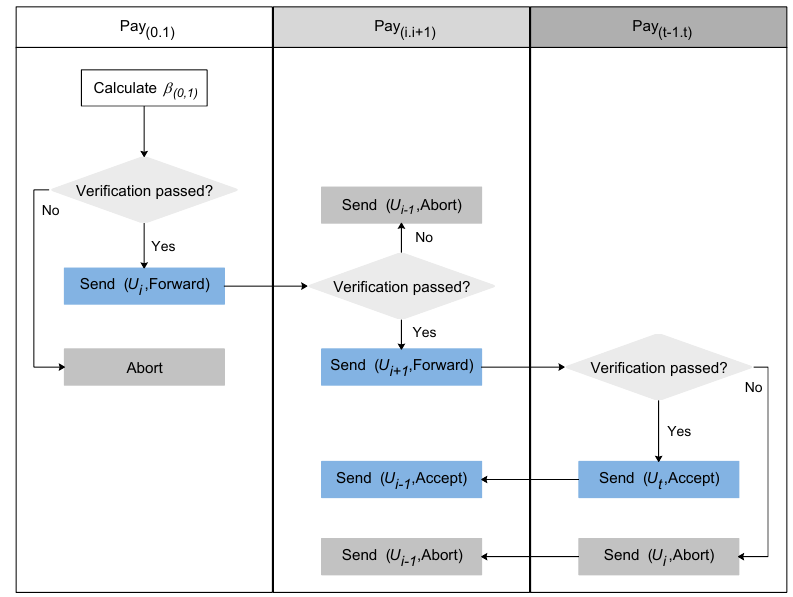
Figure 4. Core process of PCN-based trading